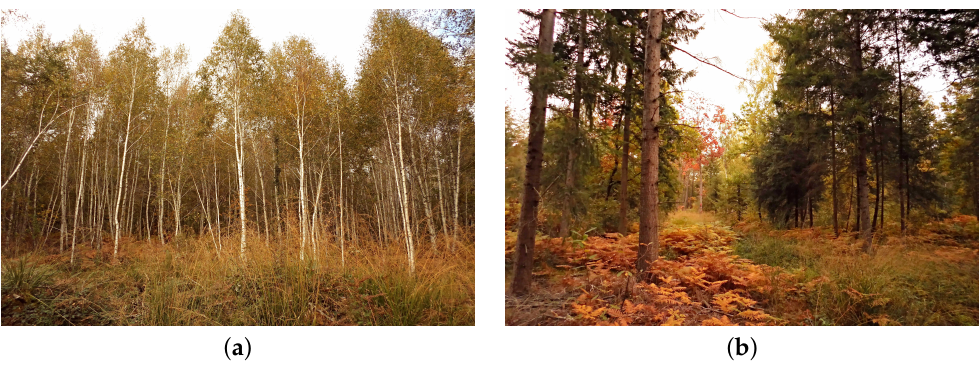
Figure 8. Examples of homogeneous and heterogeneous forest areas of the study site. At level 3, mixed forests show a high classification instability between the classifiers. ( a ) Monospecific forest composed of Silver birch; ( b ) Mixed forest composed of various deciduous and conifer